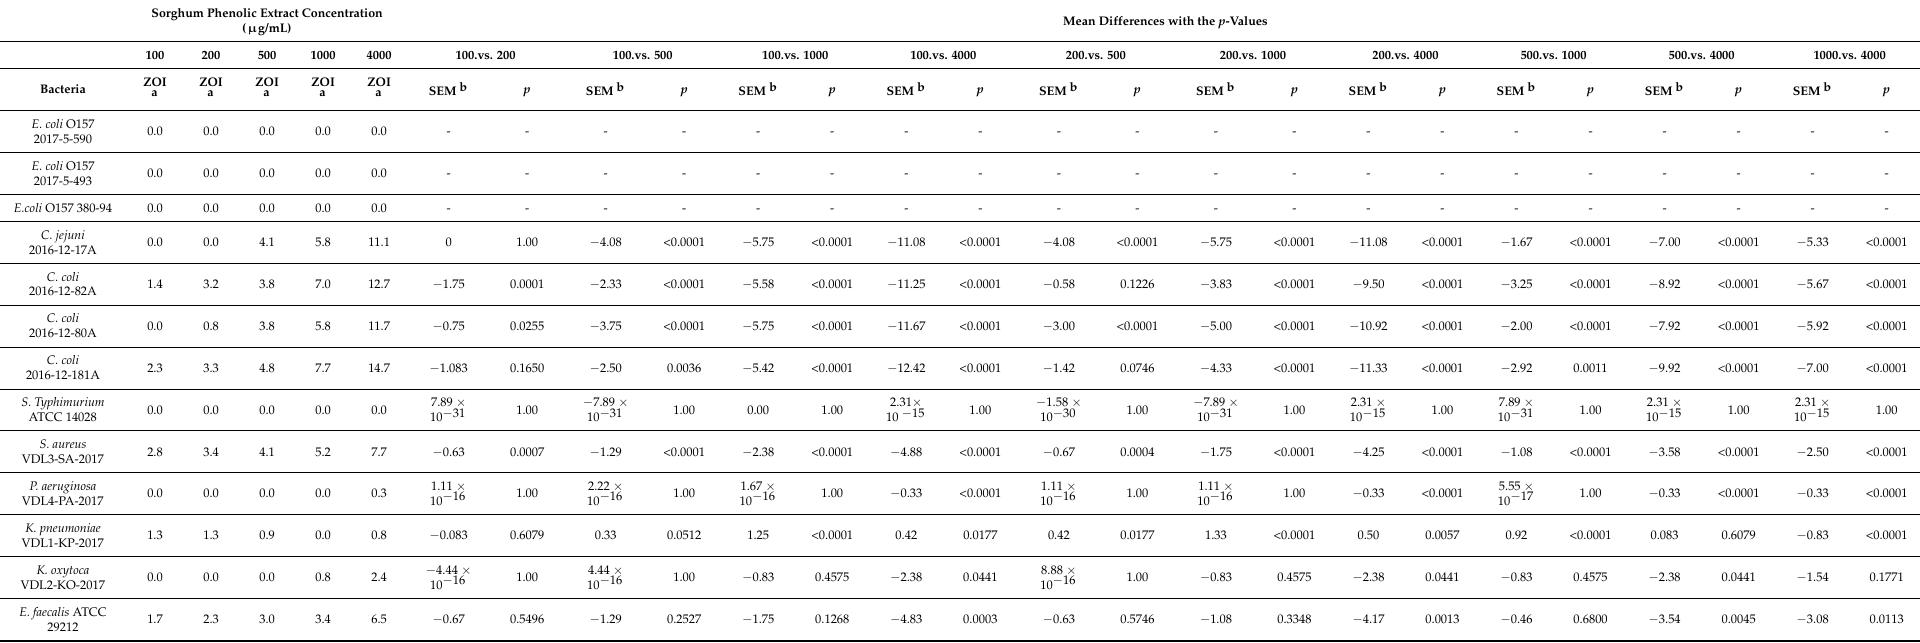
Table 2. Antimicrobial effects of different sorghum phenolic extract